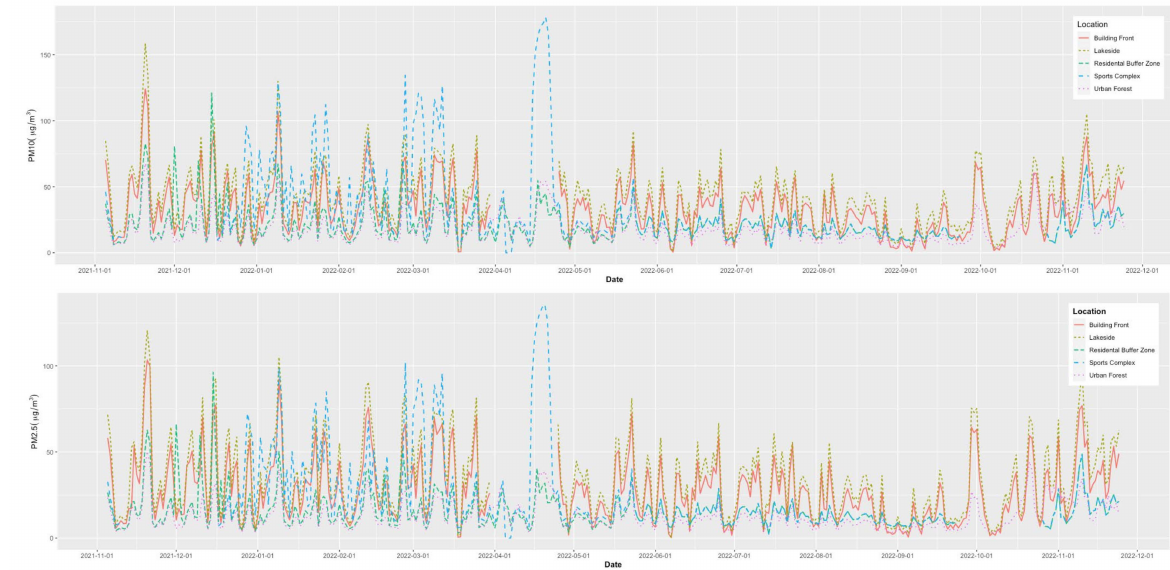
Figure 7. Time-series analysis of PM 10 and PM 2.5 concentration levels at the five